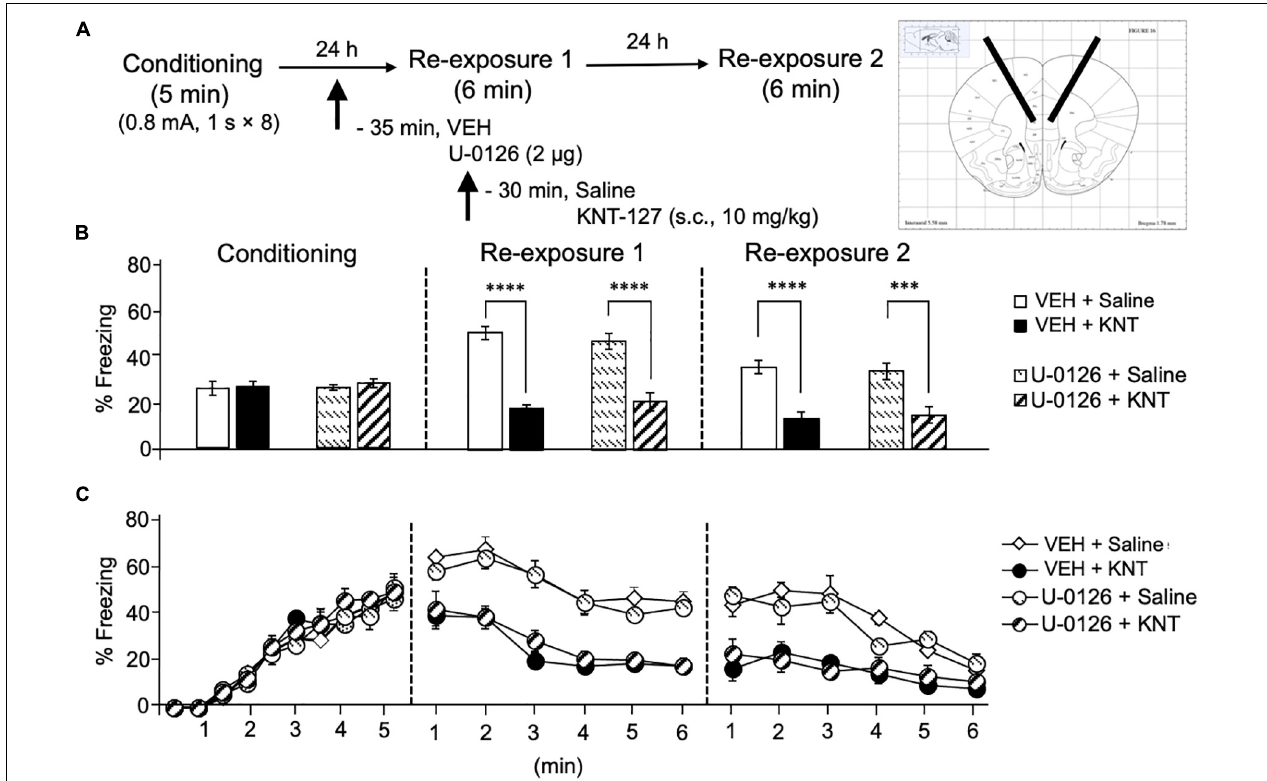
FIGURE 5 | Intra-IL administration of MEK/ERK inhibitor did not affect the fear reduction induced by KNT-127. (A) Experimental design. Mice were subcutaneously administered with saline or KNT-127 (10 mg/kg) 30 min before reexposure 1 (6 min). Five minutes before injecting these drugs, a vehicle or a MEK inhibitor, U-0126, was administered bilaterally into the BLA (35 min before reexposure 1). Twenty-four hours after reexposure 1, a fear memory was tested in the same context for 6 min (reexposure 2). (B) Freezing rates of mice during conditioning, reexposures 1 and 2. U-0126 abolished the effects of KNT-127 during reexposures 1 and 2. The number of mice in each group was as follows: n = 5 for vehicle and subsequent saline (VEH + saline), n = 5 for vehicle and subsequent KNT-127 (VEH + KNT), n = 5 for U-0126 and subsequent saline (U-0126 + saline), and n = 5 for U-0126 and subsequent KNT-127 (U-0126 + KNT). (C) Time course of the freezing rates of mice during conditioning, reexposures 1 and 2. Data are expressed as the means ± SEM. Data were expressed as mean ± SEM. ∗∗∗ p < 0.001, ∗∗∗∗ p < 0.0001 for comparisons between KNT-127 and U-126 treatment groups, by two-way ANOVA and post hoc Bonferroni’s